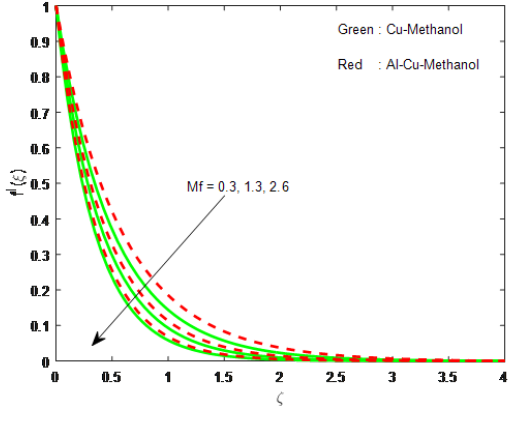
Fig. 14: Impression of Mf on f (cid:48) ( ξ )